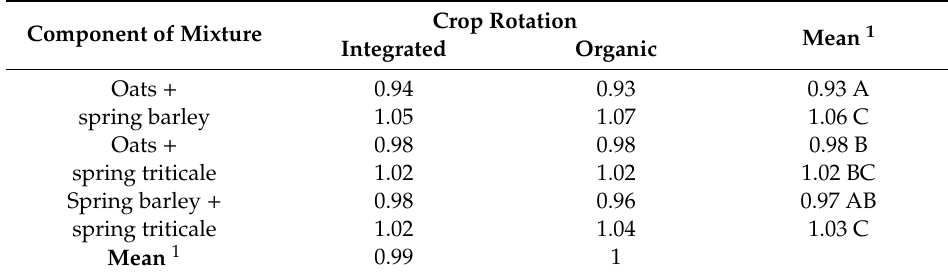
Table 9. Values of competitive ratio (CR) of the components of the spring cereal mixtures, means for the years 2011–2019.